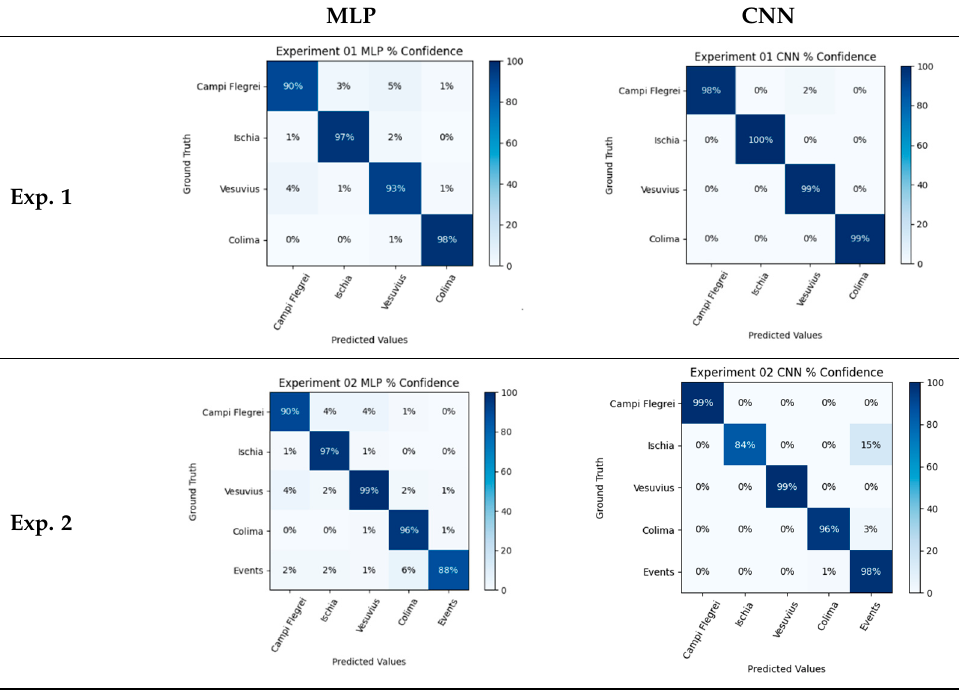
Table 5. Normalized confusion matrices for the MLP and CNN models for the two experiments.